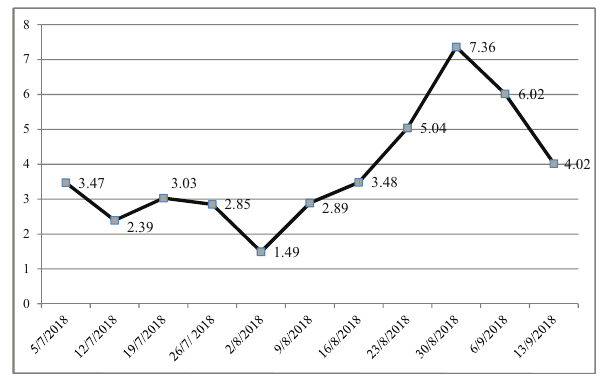
Figure 2: Soil salinity level during observation ( ds/m )